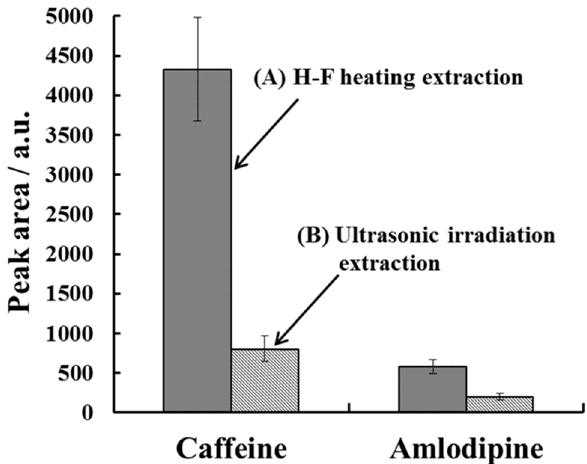
Figure 6. The extraction profiles of caffeine and amlodipine for nails from a hypertension patient. (A) H-F heating extraction (3 min; 220 °C) and (B) ultrasonic irradiation extraction (30 min). The other parameters were the same as in Figure 5. Error bars represent the standard deviation ( n = 3). Molecules 2017 , 22 , x FOR PEER REVIEW